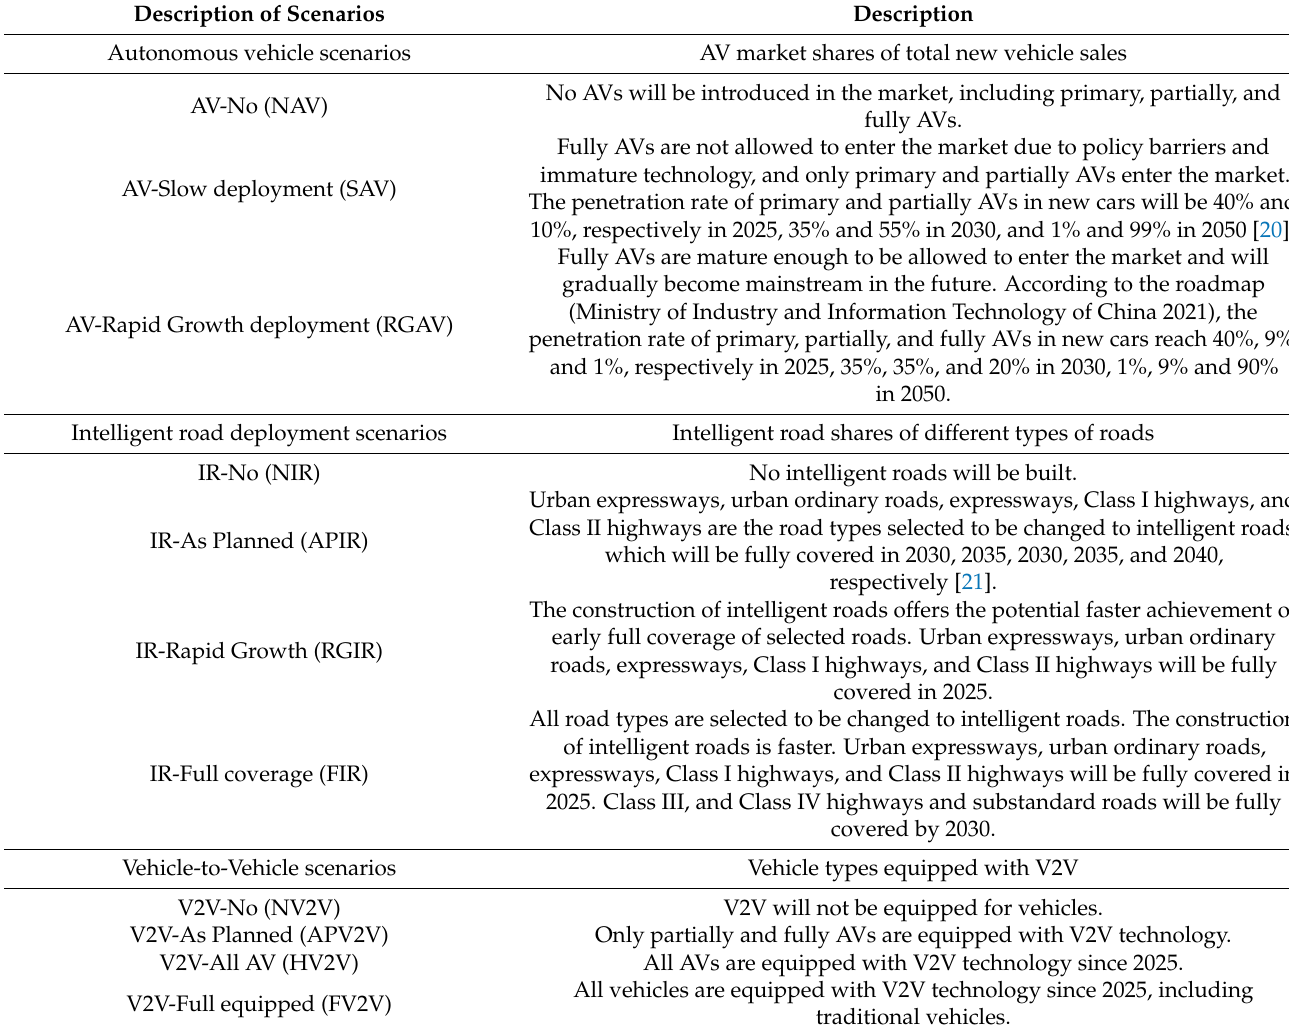
Table 1. Description of the dimensions which are combined to generate the 48